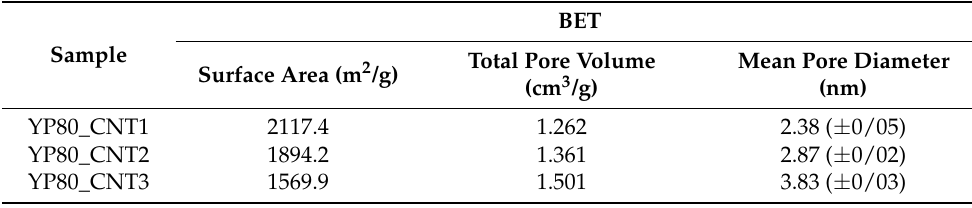
Figure 3. TEM and HRTEM analyses of the surface state and particle shape of the electrode after the electrode reaction; ( a , b ) YP80_CNT1, ( c , d ) YP80_CNT2, and ( e , f ) YP80_CNT3. Table 1. Some physical parameters obtained from the BET